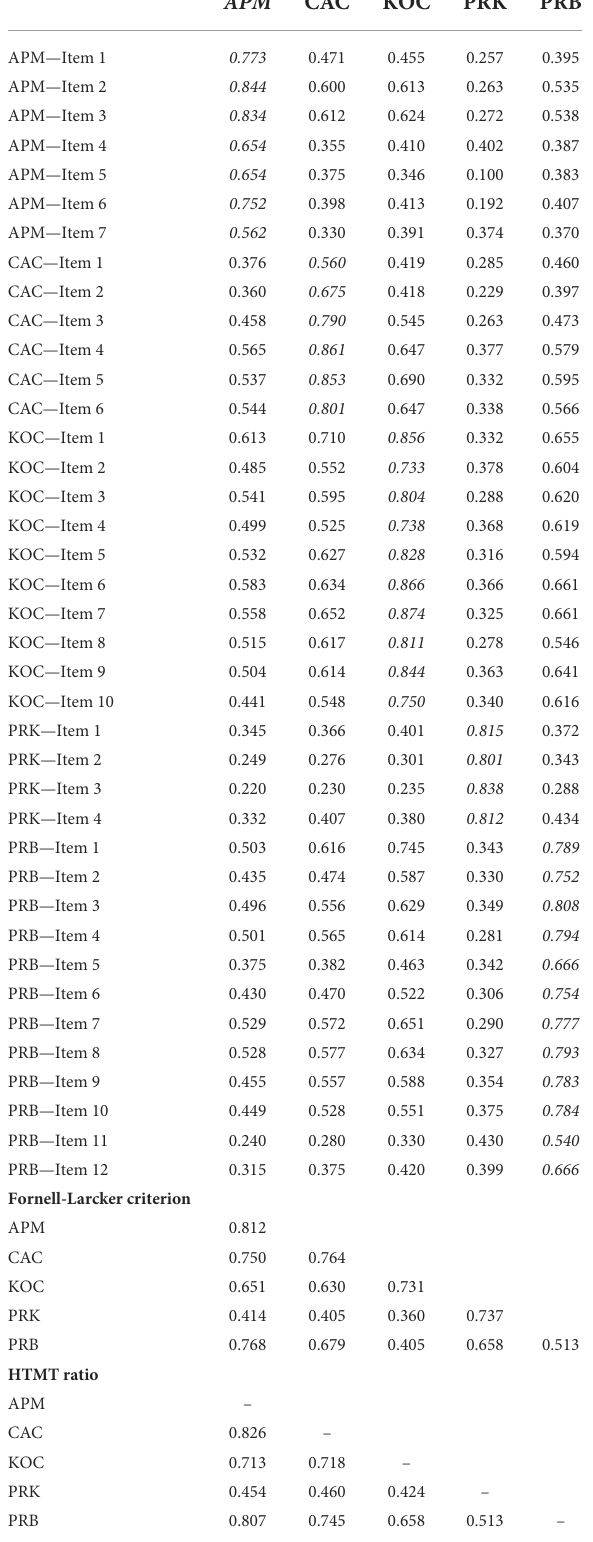
TABLE 10 Outer loading and cross